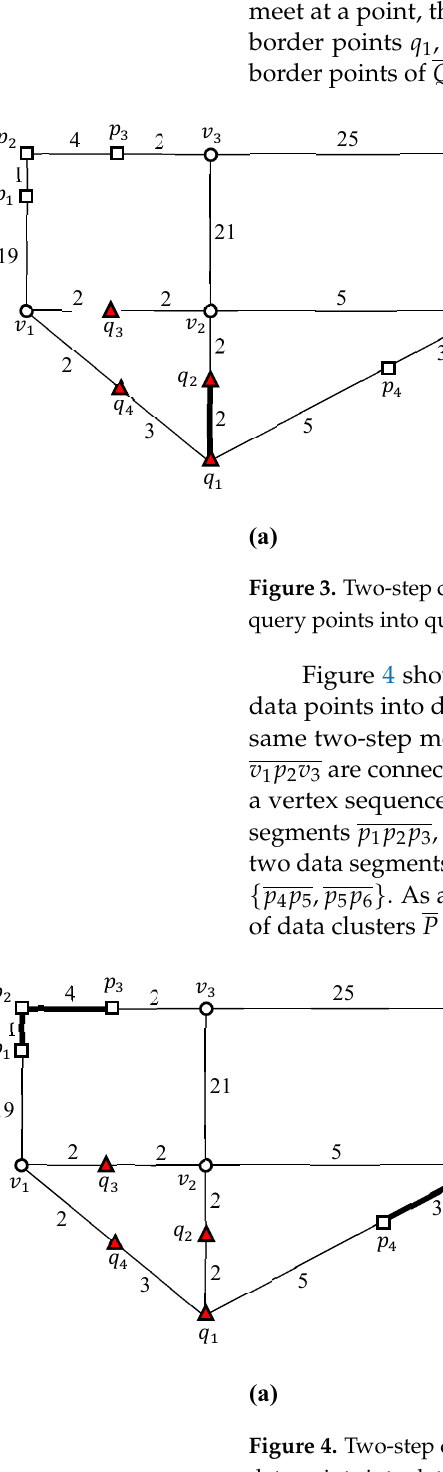
The maximum and minimum distances between a border point b q and a data